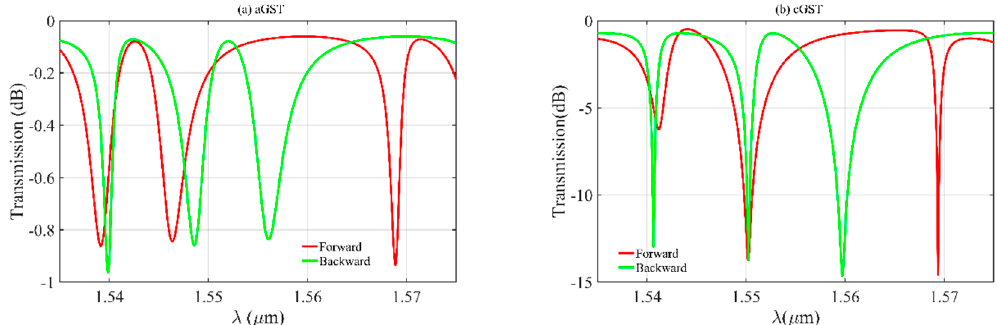
Figure 3. Transmission spectra of 1 × 3 MOMRs with ( a ) aGST and ( b ) cGST.